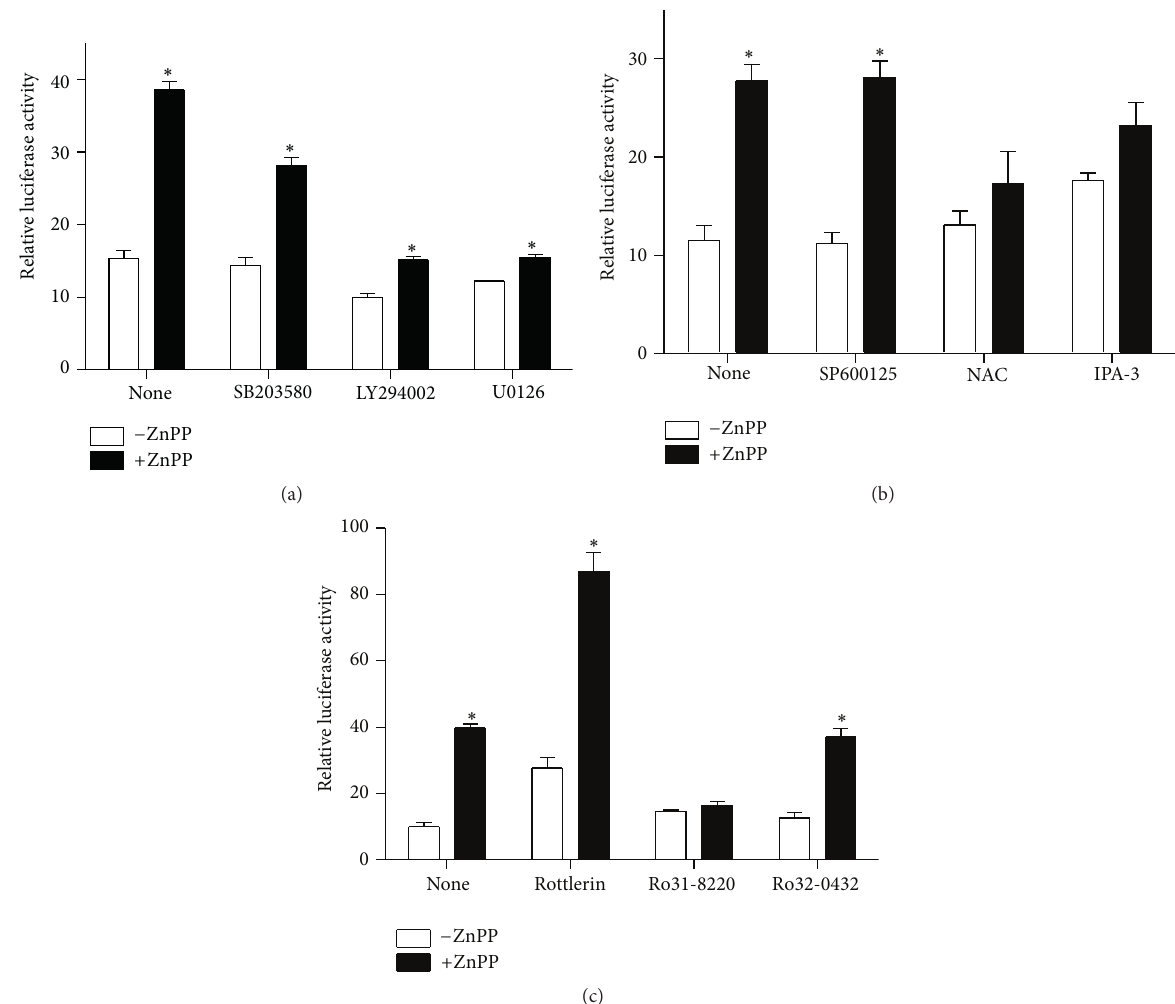
Figure 4: Effect of protein kinase inhibitors and antioxidant on ZnPP-activation of StRE3 element of human HO-1 promoter in PC-3 cells. PC-3 cells were transfected with StRE3-pGL3 luciferase reporter plasmid, pretreated with 3 𝜇 M SB203580, 5 𝜇 M LY294002, 10 𝜇 M U0126, 3 𝜇 M SP600125, 500 𝜇 M NAC, 10 𝜇 M IPA-3, 2 𝜇 M rottlerin, 5 𝜇 M Ro 31-8220, or 5 𝜇 M Ro 32-0432 for 2h, and then treated with 10 𝜇 M